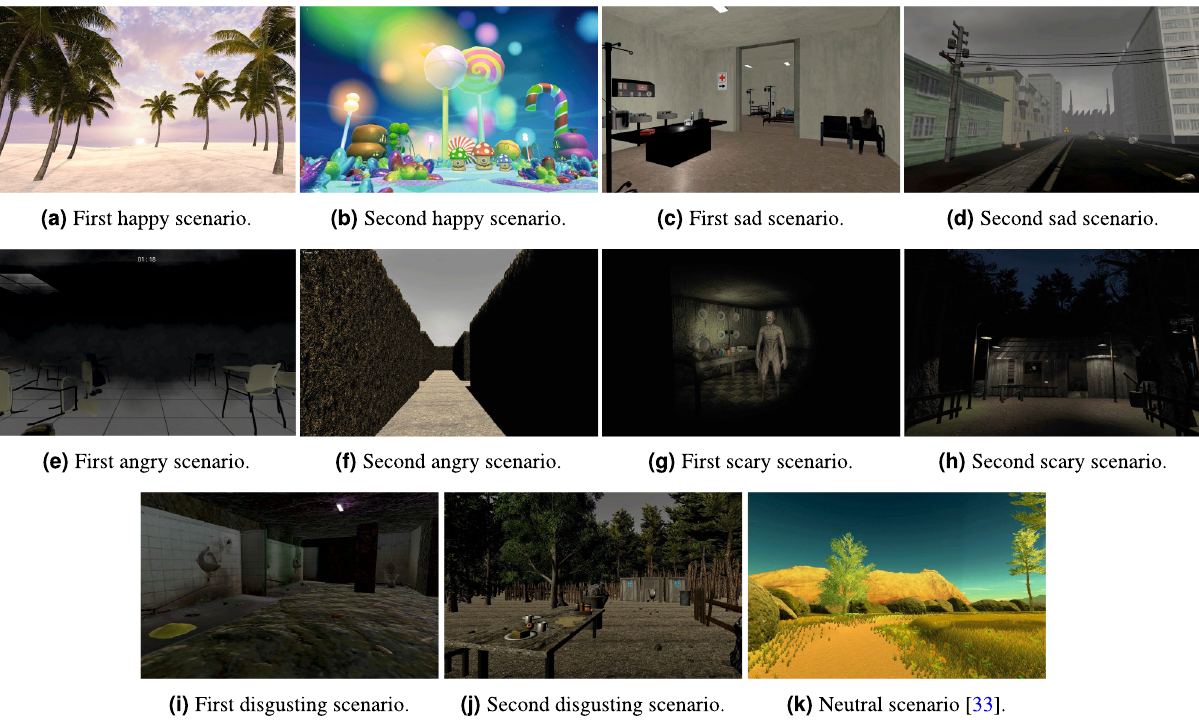
Figure 1. Details of the affective VR environments used to elicit Happiness, Sadness, Anger, Fear, Disgust, and